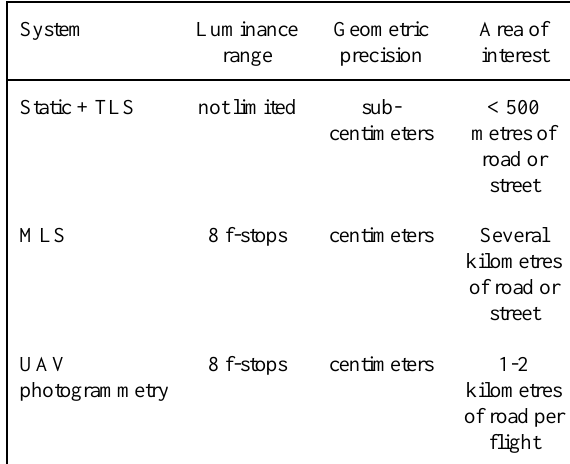
Figure 12. Luminance point cloud from UAV measurement. Figure 13 illustrates a composition of two nadir images from the photogrammetric block used for the 3D reconstruction.